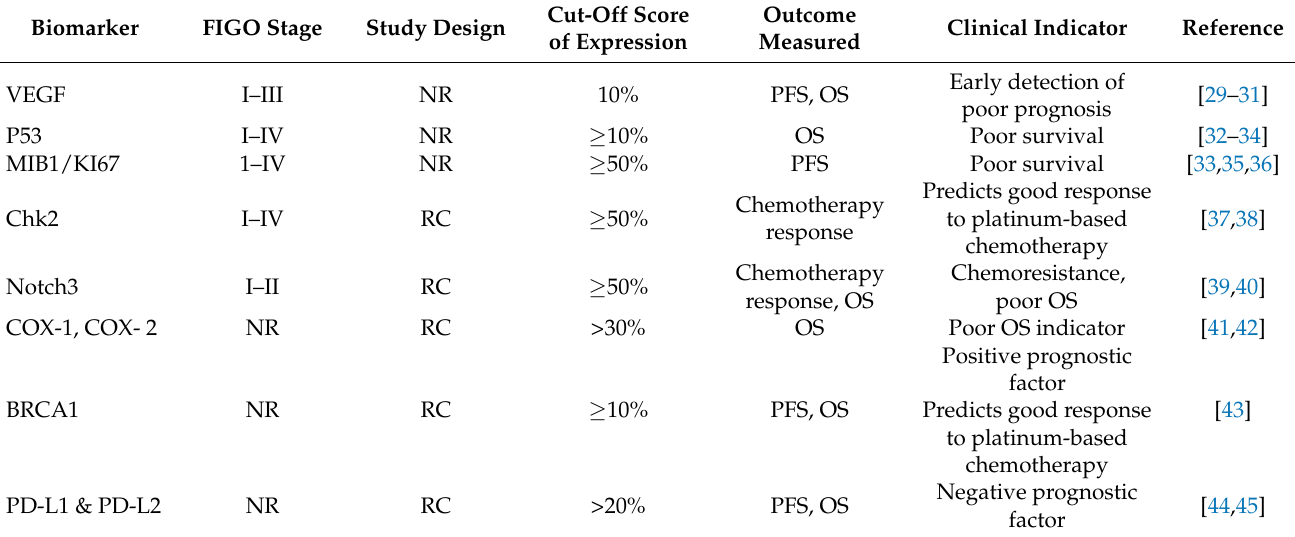
Table 1. Summary of IHC biomarkers associated with chemoresistance and prognosis in EOC.